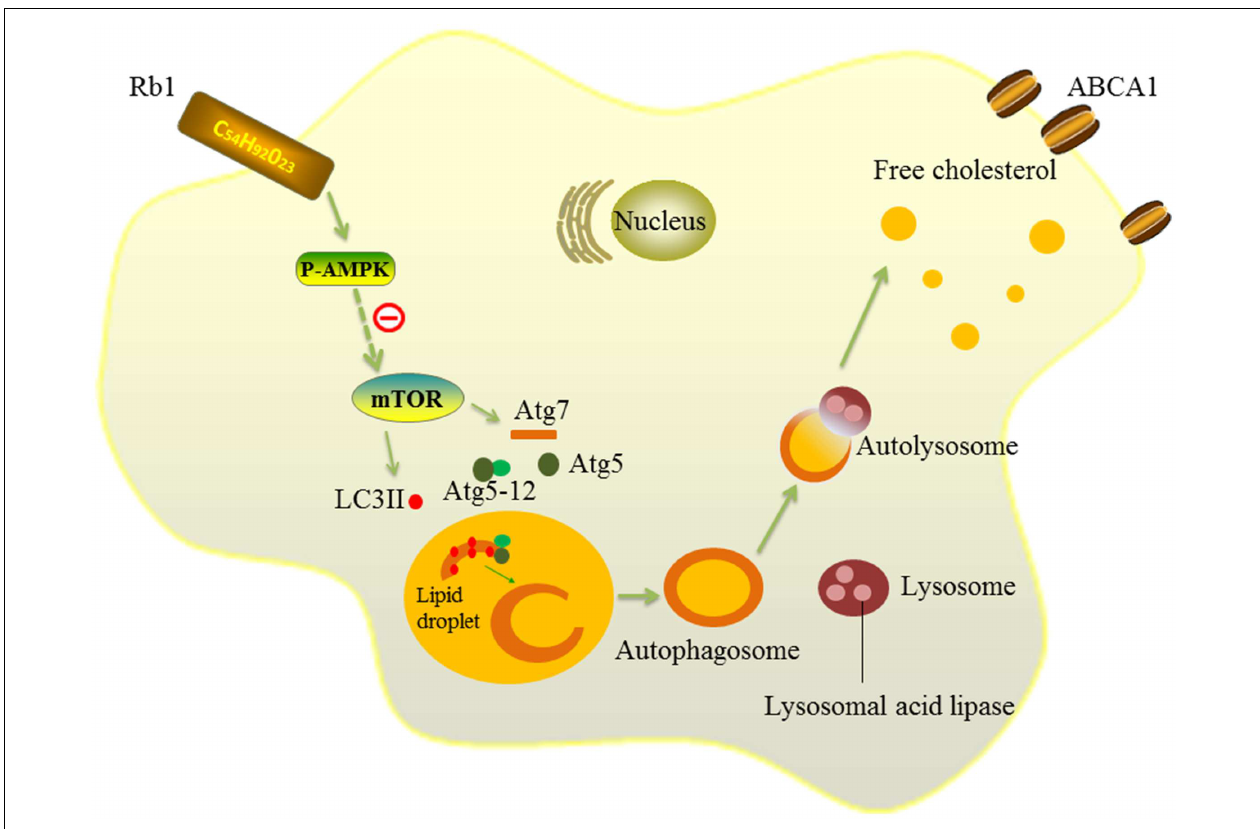
FIGURE 7 | Schematic diagram of the effects of Rb1 on autophagy. Rb1 increased AMPK phosphorylation and thus induced autophagy activation in macrophage foam cells. Lipid droplets (LDs) are separated by double-membrane vesicles analogous to autophagosomes and delivered to lysosomes to form an autolysosome. LDs are hydrolyzed by lysosomal acid lipase (LAL) into free cholesterols in the autolysosome. Solid lines ( ) depict the mechanism by which Rb1 improves autophagy and lipid metabolism in macrophage foam cells in our present study. Dotted lines( ) represent a possible signaling molecule (mTOR) that may serve as an upstream regulator of autophagy induced by Rb1, but was not investigated in our